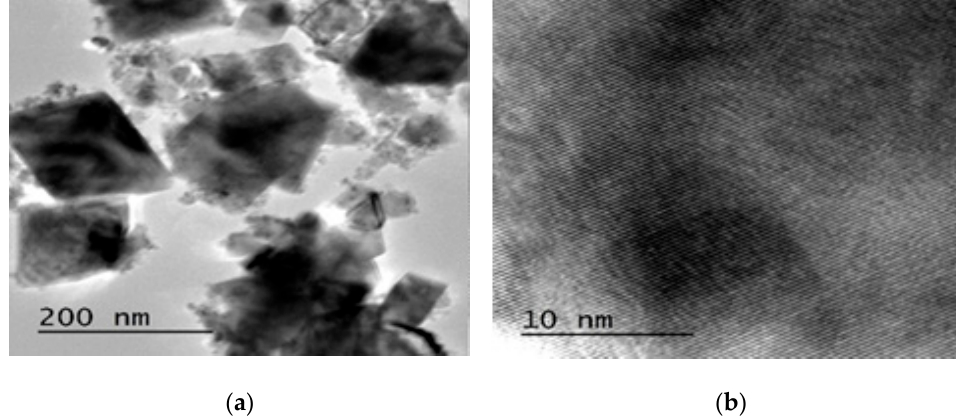
Figure 3. ( a ) TEM and ( b ) HRTEM images of MnFe 2 O 4 prepared by hydrothermal processing at 180 °C.